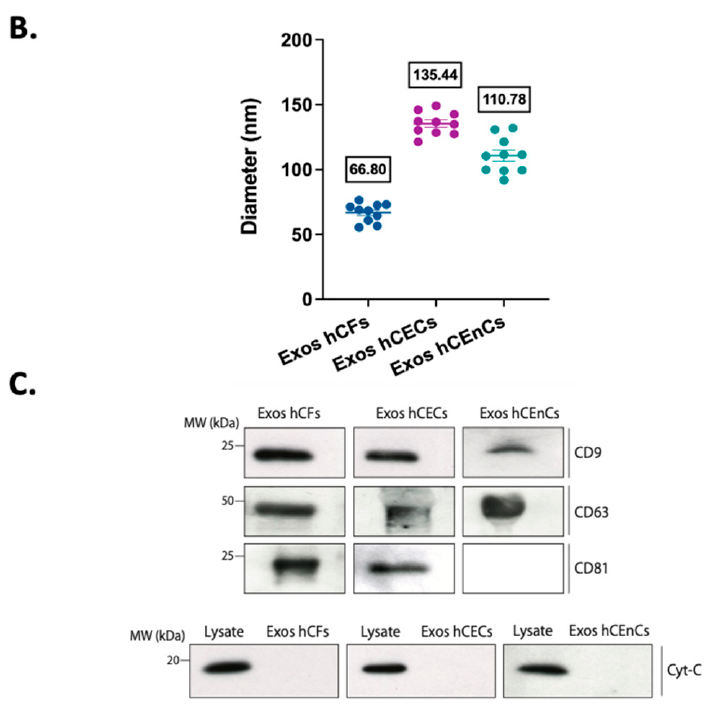
Figure 1. Characteristics of the exosomes isolated from the three corneal cell types. ( A ) TEM images of exosomes isolated from hCFs, hCECs and hCEnCs showing a range of exosomal size from 30–150 nm and a round morphology. Scale bars: 100 nm or 200 nm. ( B ) The diameter of the exosomes isolated from the three corneal cell types were analyzed by DLS. The means for the 10 measurements (repeated measures) were calculated and plotted on a graph. ( C ) Western Blot analysis of three specific exosomal markers (CD9, CD63 and CD81) as well as one negative marker (cytochrome c) in exosomes isolated from conditioned medium of hCFs, hCECs and hCEnCs. Corresponding cell lysate were used as a positive control for cytochrome c.